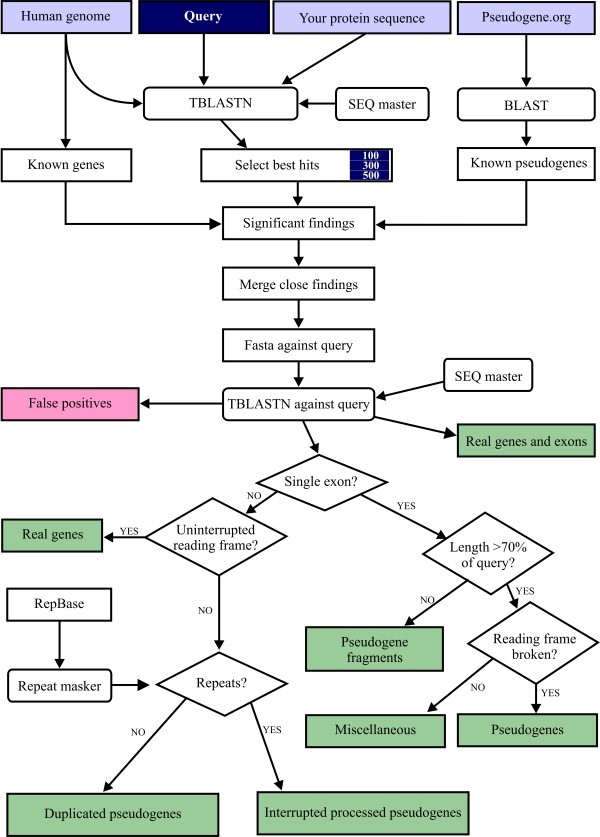
Overview of the search algorithm of PseudoGeneQuest service. User provides the protein query sequence and the number of best hits wanted. The algorithm provides seven types of results in addition to the known genes and pseudogenes (see Table 1). The chart is a modified version of Figure 1 from [9].